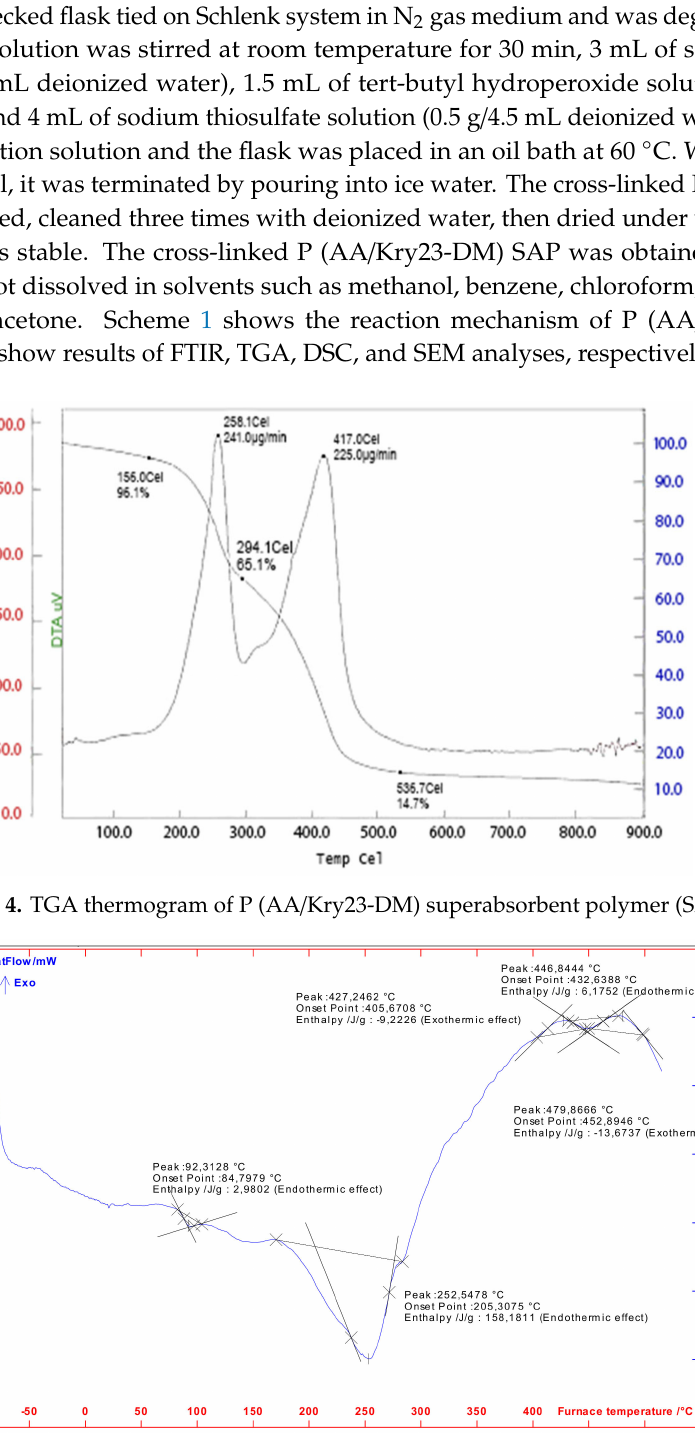
Figure 5. DSC thermogram of P(AA / Kry23-DM)